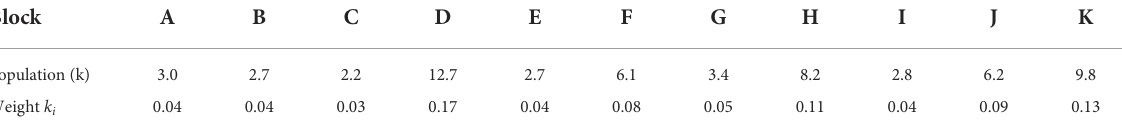
TABLE 5 Weight of each neighborhood for adjusting street walkability of the study area.